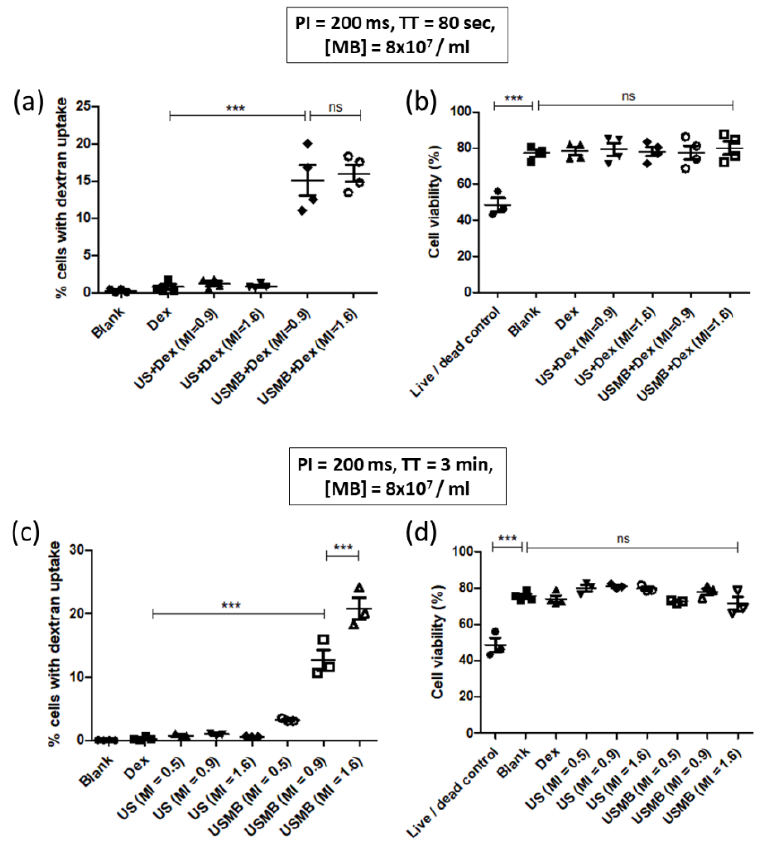
Figure 7. Variation of 70 kDa and 4 kDa dextran delivery in CMT167 cells with variation in MI. ( a ) Plot showing percentage of CMT167 cells with 70 kDa dextran uptake for different treatment groups as MI of ultrasound was varied. The proportion of dextran positive cells increased significantly at MI of 0.9, compared to controls ( p < 0.001). There was no significant increase in the dextran positive cells when MI was increased to 1.6 ( p > 0.05). ( b ) Plot showing cell viability (%) for different treatment groups shown in panel ( a ). The cell viability did not change significantly in groups treated with USMB, compared to the controls. ( p > 0.05) ( c ) Plot showing percentage of CMT167 cells with 4 kDa dextran uptake for different treatment groups as MI of ultrasound was varied. The proportion of dextran positive cells increased significantly at MI of 0.9, compared to controls ( p < 0.001). Increasing the MI to 1.6 led to a significant increase in the proportion of dextran positive cells, compared to MI of 0.9 ( p < 0.001). ( d ) Plot showing cell viability (%) for different treatment groups shown in panel ( c ). The cell viability did not change significantly in groups treated with USMB, compared to the controls ( p > 0.05). In all the experiments, coverslips were incubated for 1 min at 37 ◦ C. One-way ANOVA with post-hoc Tukey’s test was used for assessing statistical significance in all the groups. In all the figures, *** represents p <